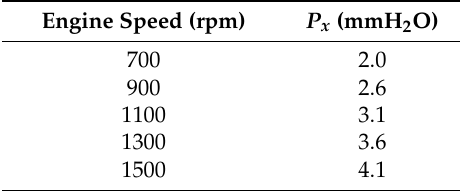
Table 2. Differential pressure according to the engine speed . Table 2. Di ff erential pressure according to the engine speed.